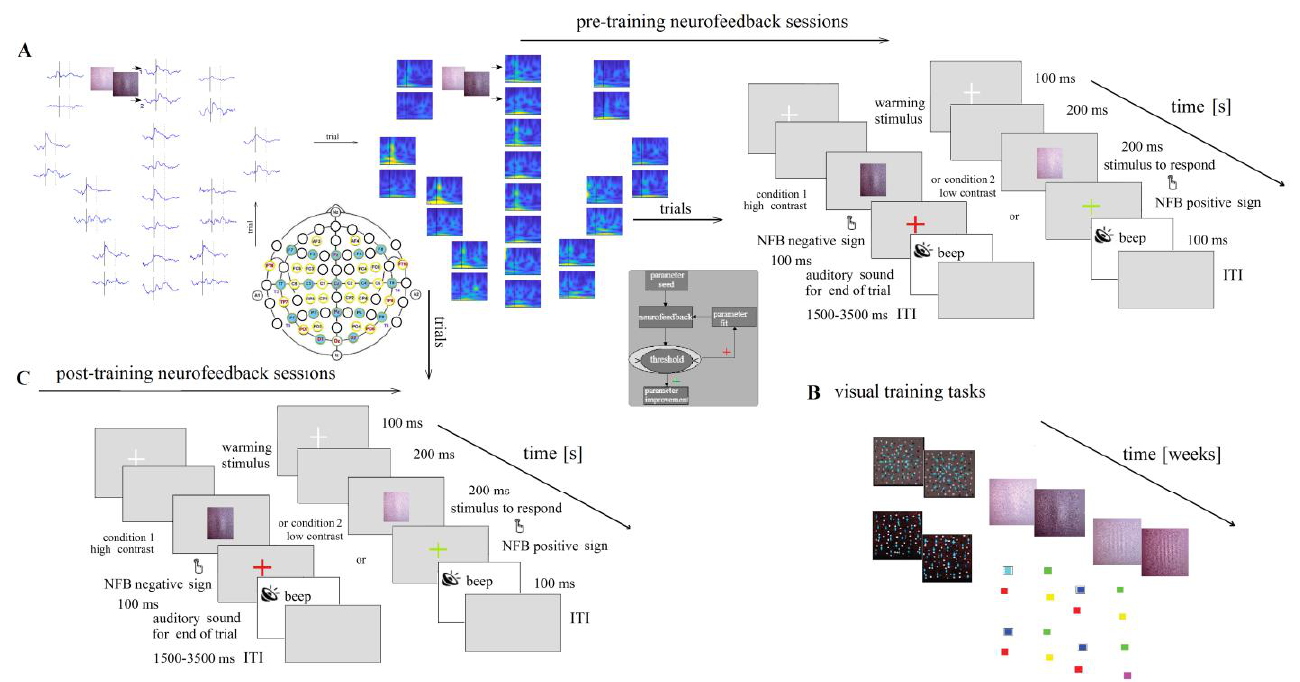
Figure 5. Scheme of experimental set-up. ( A ) EEG signals and frequency analysis at the EEG signals. Presentation of pre-training neurofeedback sessions: six sessions (for each hemisphere). ( B ) Visual training (VT) tasks, described in Supplementary Materials. ( C ) Post-training neurofeedback.